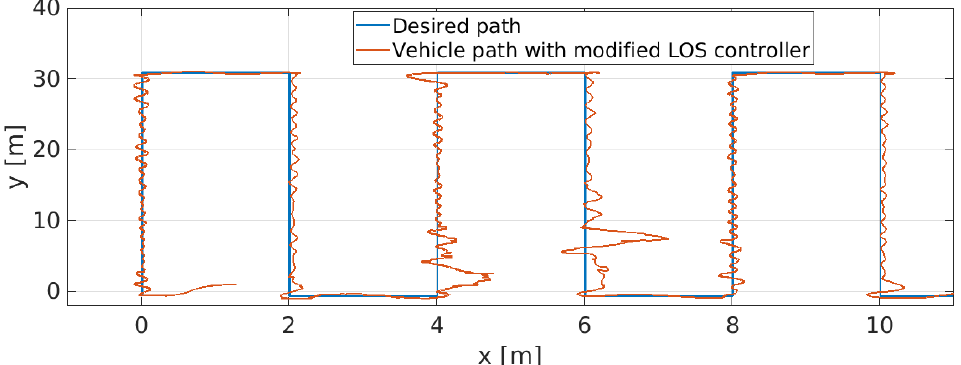
Figure 20. Vehicle’s path, employing the ALICE configuration along the test mission.